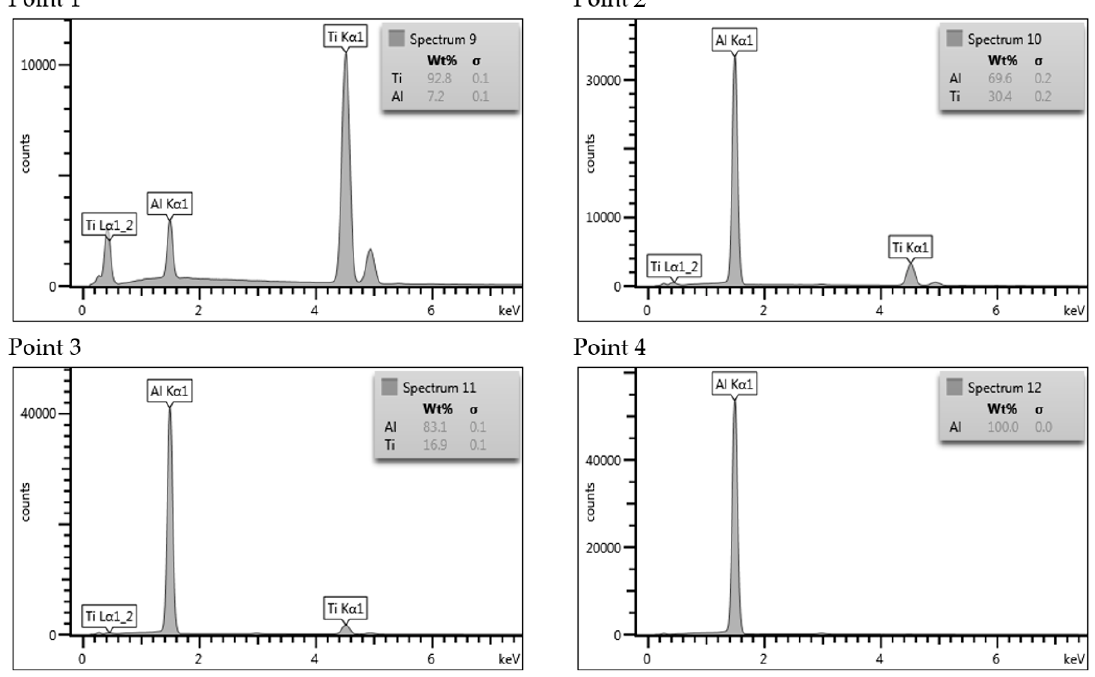
Figure 16. Element compositions corresponding to the spectrums in Figure 15B.